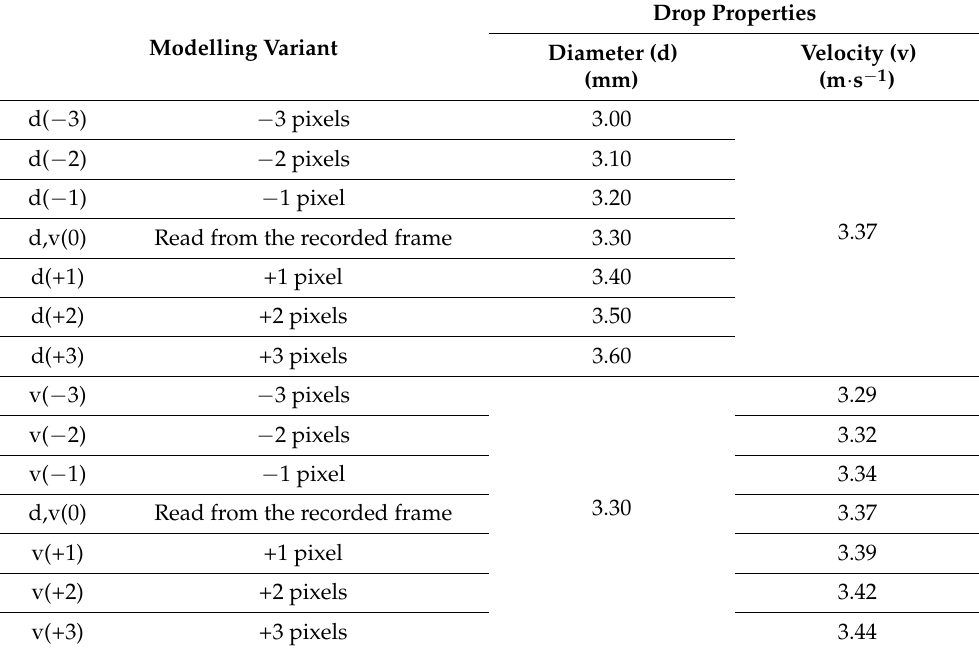
Table 2. Symbols and input data for 13 variants of